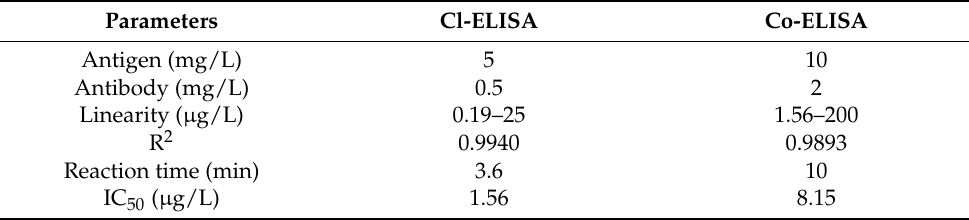
Table 3. Comparison between Cl-ELISA and Co-ELISA.